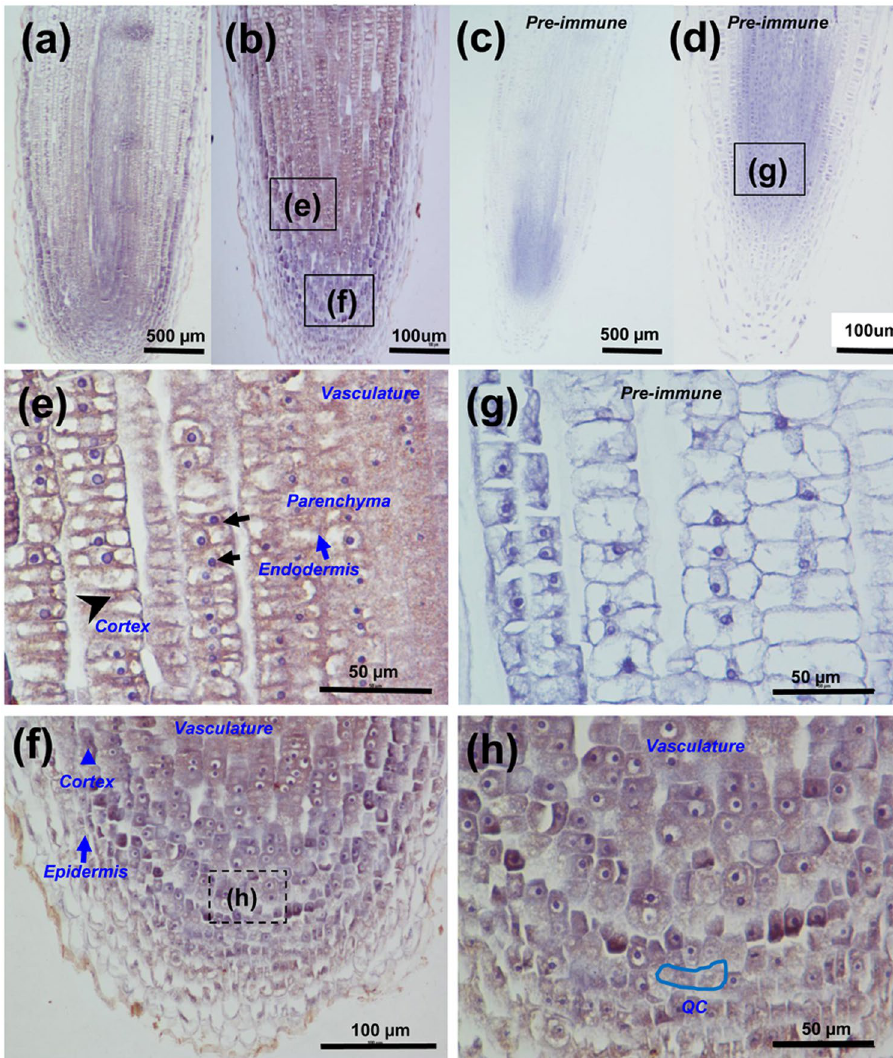
Figure 3. Immunohistochemical analysis of CsGPA1 in cucumber root tips. An anti-CsGPA1 monoclonal antibody ( a , b ) and pre-immune serum ( c , d ) were used to analyze longitudinal sections of the root tips of 4-leaf- old plants for CsGPA1 expression. Scales = 50, 100 and 500 µ m. ( e – g ) Magnified views of the images in ( b , d ). ( h ) Magnified view of the areas boxed in ( f ), respectively. Black arrows indicate the nucleus, blue arrows indicate the cell layers of the root meristem, and black arrowheads indicate the specific distribution of immunostaining in the root tip cortex as well as epidermal, endodermal, parenchymal and phloem cells. QC, quiescent